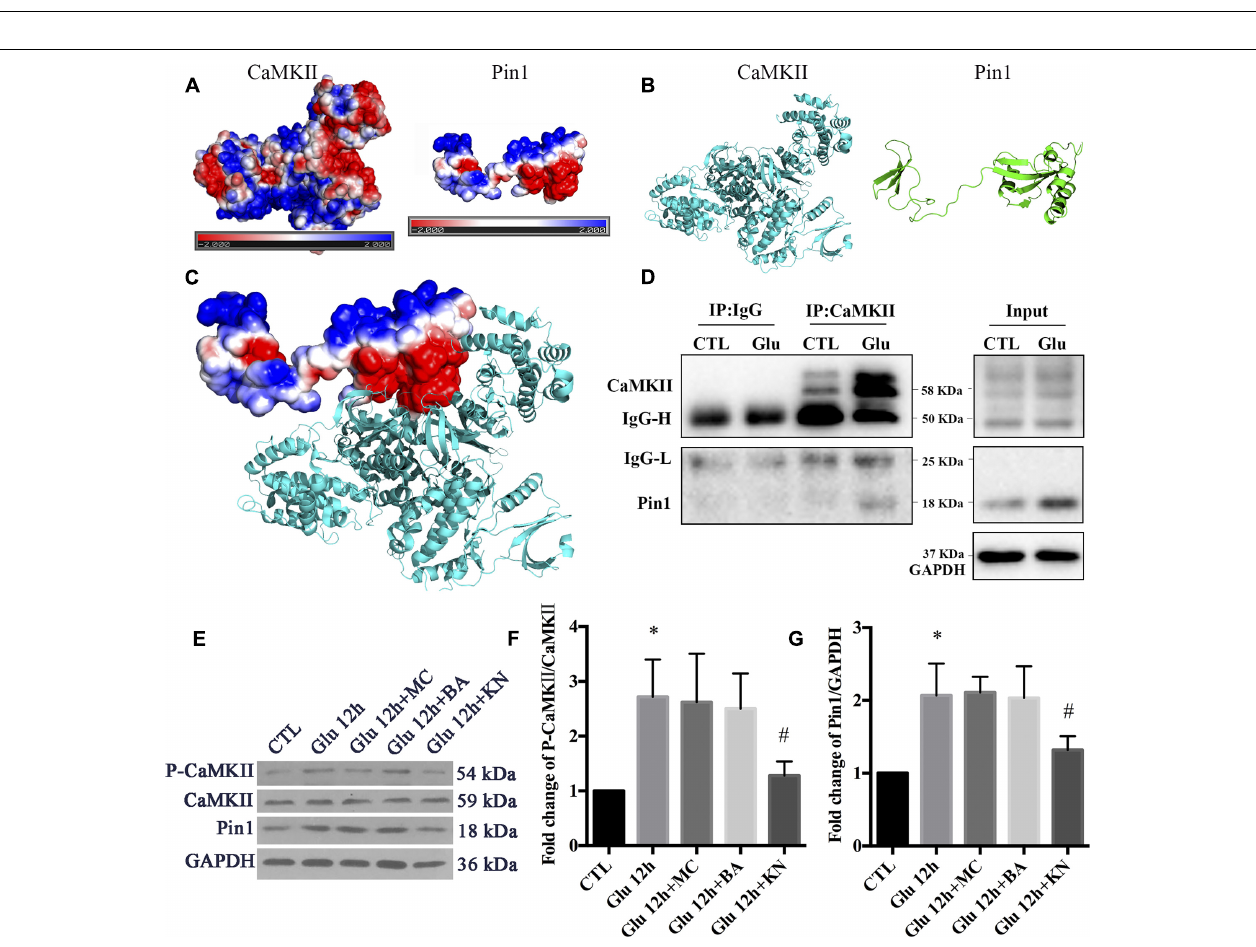
FIGURE 4 | Expression of CaMKII, p-CaMKII and Pin1 in retinal neurons following glutamate treatment. (A) Western blot of CaMKII, p-CaMKII and Pin1 expression. (B) The statistical analysis of p-CaMKII/CaMKII expression. (C) The statistical analysis of Pin1 expression. MC was used at a concentration of 50 µ M, 30 min before glutamate insult. N = 3 cultures. Data were analyzed using one-way ANOVA. ∗ p < 0.05 vs. CTL group.